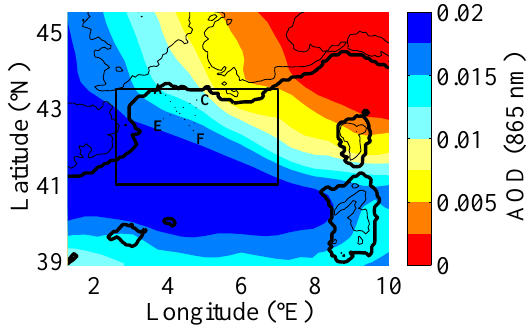
Fig. 9. Simulated sea-salt optical depth (AOD) at 865nm derived from CHIMERE simulation at 12:00UTC (domain 2). The dotted line corresponds to the flight track of the ARAT carrying the water vapor lidar LEANDRE-2 on 24 March 1998 in the afternoon.